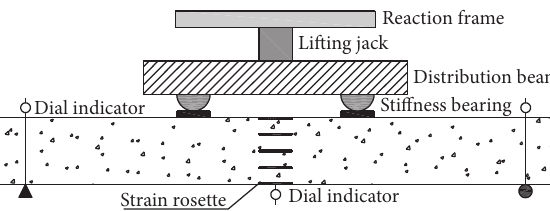
Figure 8: Loading diagram of test beam.